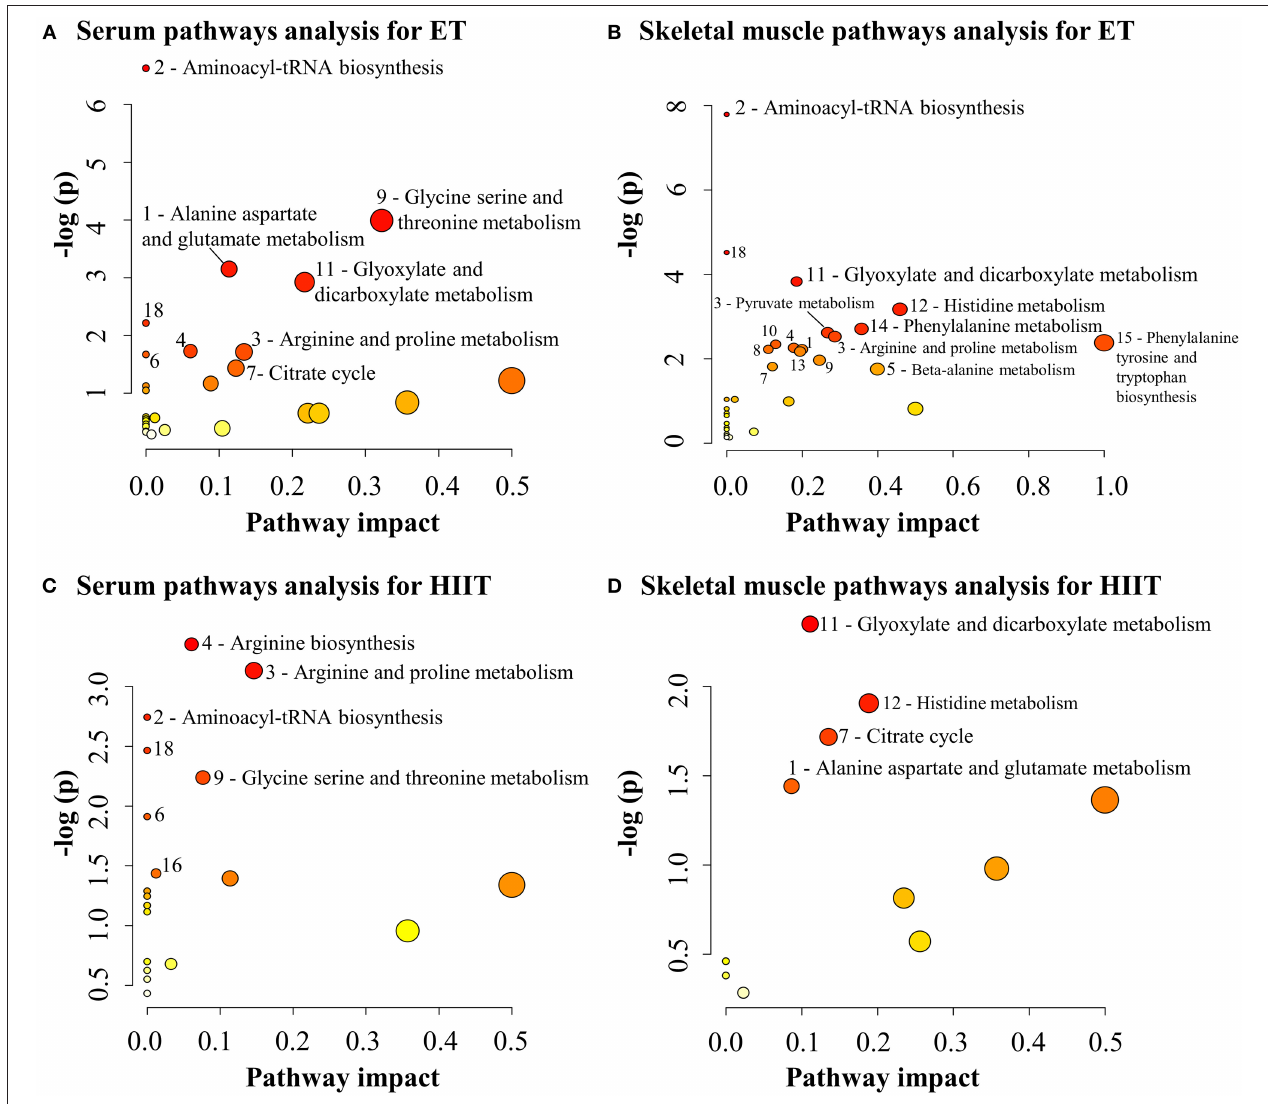
FIGURE 1 | Summary of altered metabolic pathways and their metabolites associated with maximal power output gains after endurance training (ET) and high intensity interval training (HIIT). The numbers and labels in the figures represent the most enriched and impacted pathways. All numbered pathways have significance for a false discovery rate of 0.1 (vertical axis). The pathway’s impact on the horizontal axis represents the relative contribution of all identified metabolites in relation to those that compose it. (1) Alanine, aspartate and glutamate metabolism ( A : asparagine, glutamine, citrate and succinate; B : alanine, pyruvate, glutamine and fumarate; C : glutamine and succinate; D : N-acetylaspartate and citrate); (2) Aminocyl-tRNA biosynthesis ( A : asparagine, histidine, phenylalanine, glutamine, glycine, methionine, valine and threonine; B : histidine, phenylalanine, glycine, alanine, isoleucine, leucine, threonine, tyrosine, proline, valine and glutamate; C : phenylalanine, glutamine, valine and isoleucine); (3) Arginine and proline metabolism ( A : ornithine, guanidinoacetate, creatine phosphate; B : ornithine, glutamate, proline, creatine, and pyruvate; C : ornithine, guanidinoacetate, creatine, and creatine phosphate); (4) Arginine biosynthesis ( A : ornithine and glutamine; B : glutamate, ornithine, and fumarate; C : ornithine, glutamine, and urea); (5) Beta-alanine metabolism ( B : beta-alanine, anserine and histidine); (6) Butanoate metabolism ( B , C : 3-hydroxybutyrate and succinate); (7) Citric acid cycle ( A : succinate and citrate; B : isocitrate, pyruvate and fumarate; D : isocitrate and citrate); (8) Glutathione metabolism ( B : glycine, glutamate, NADP + and ornithine); (9) Glycine, serine and threonine metabolism ( A : choline, betaine, guanidinoacetate, glycine and threonine; B : glycine, threonine, creatine and pyruvate; C : betaine, guanidinoacetate and creatine); (10) Glycolysis or gluconeogenesis ( B : pyruvate, lactate, glucose and acetate); (11) Glyoxalate and dicarboxylate metabolism ( A : glycolate, citrate, glycine, and glutamine; B : glycolate, glycine, glutamate, acetate, isocitrate, and pyruvate; C : isocitrate, glycolate and citrate); (12) Histidine metabolism ( B : glutamine, histidine, anserine and histamine; D : anserine and histamine); (13) Nicotinate and nicotinamide metabolism ( B : nicotinamide, NADP + , and nicotinate); (14) Phenylalanine metabolism ( B : phenylalanine, 2-hydroxyphenylacetate and tyrosine); (15) Phenylalanine tyrosine and tryptophan biosynthesis ( B : phenylalanine and tyrosine); (16) Purine metabolism ( C : xanthine and glutamine); (17) Pyruvate metabolism ( B : pyruvate, lactate, fumarate and acetate); (18) Valine, leucine and isoleucine biosynthesis ( A : threonine and valine; B : threonine, leucine, isoleucine, and valine; C : valine and isoleucine).